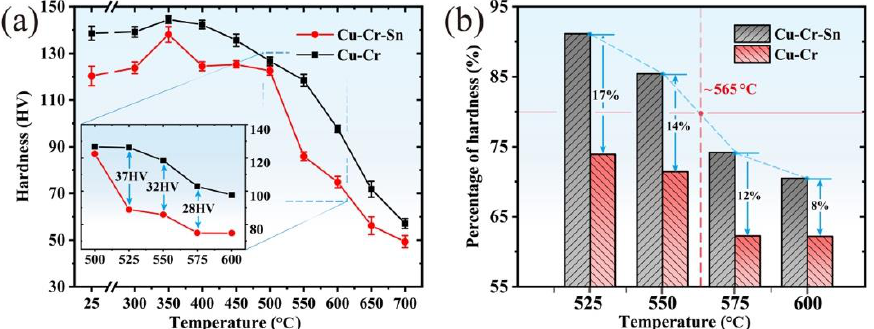
Figure 2. ( a ) Hardness and ( b ) percentage of hardness of Cu-Cr and Cu-Cr-Sn alloys during soften- ing annealing.